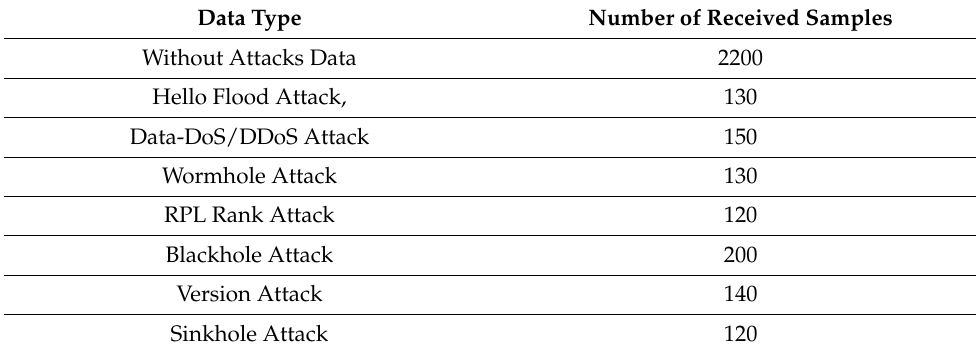
Table 4. Dataset collection of simulation in